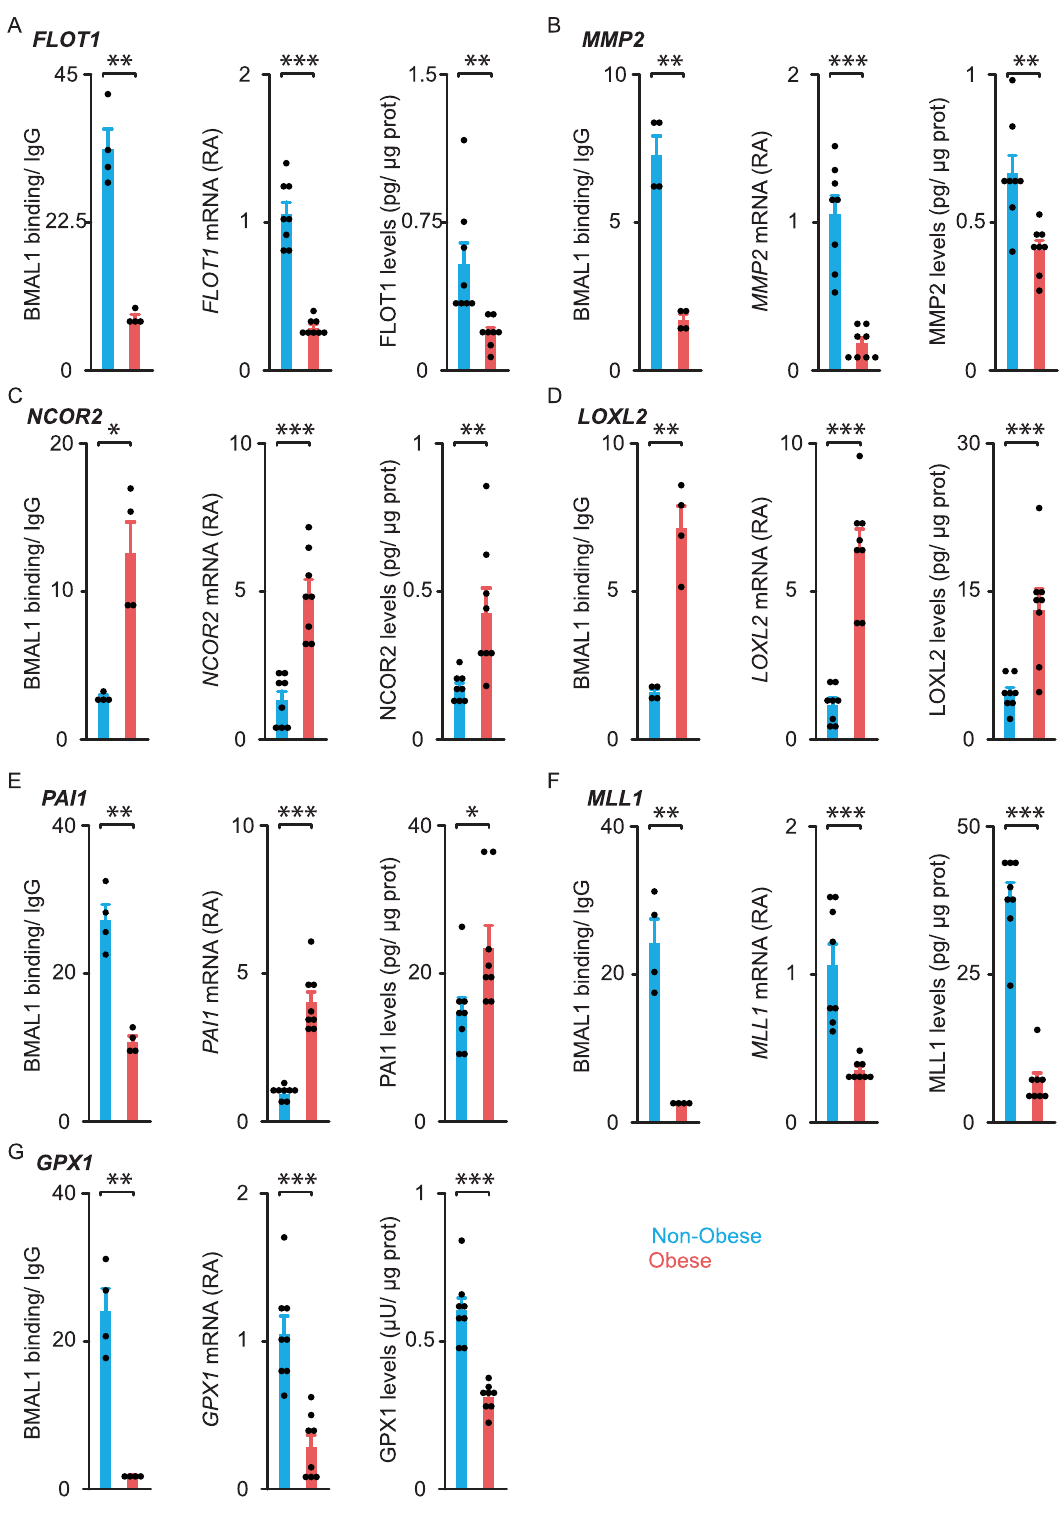
Fig. 7 BMAL1 chromatin binding to selected targets, their transcript, and protein levels in human omental adipocyte precursors from non-obese and obese subjects. We selected from Fig. 6 some BMAL1 targets for their relevance in the pathogenesis of obesity and performed, for each of them, conventional ChIP analyses, and measurements of mRNA and protein levels in OAPs. A FLOT1 Flotillin1 , B MMP2 Matrix Metalloproteinase 2 , C NCOR2 Nuclear Repressor Corepressor 2 , D LOXL2 Lysyl Oxidase Homolog 2 , E PAI1 Plasminogen Activator Inhibitor-1 , F MLL1 Histone-lysine N-methyltransferase 2A, G GPX1 glutathione peroxidase 1. ChIP data are expressed as fold enrichment over IgG, mRNAs as relative abundance (RA), and protein levels in pg or μ U/ μ g total proteins. Histograms represent the mean ± SEM for 4 (ChIP) or 8 (mRNA and protein) patients per group. p < 0.05, ** p < 0.01, *** p < 0.001 by unpaired two-tailed t- test. See also Supplementary Fig.